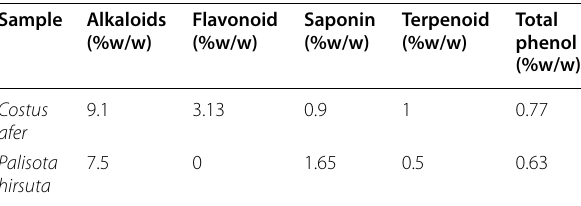
Table 5 Quantitative phytochemical constituents of methanol extracts of Costus afer and Palisota hirsuta